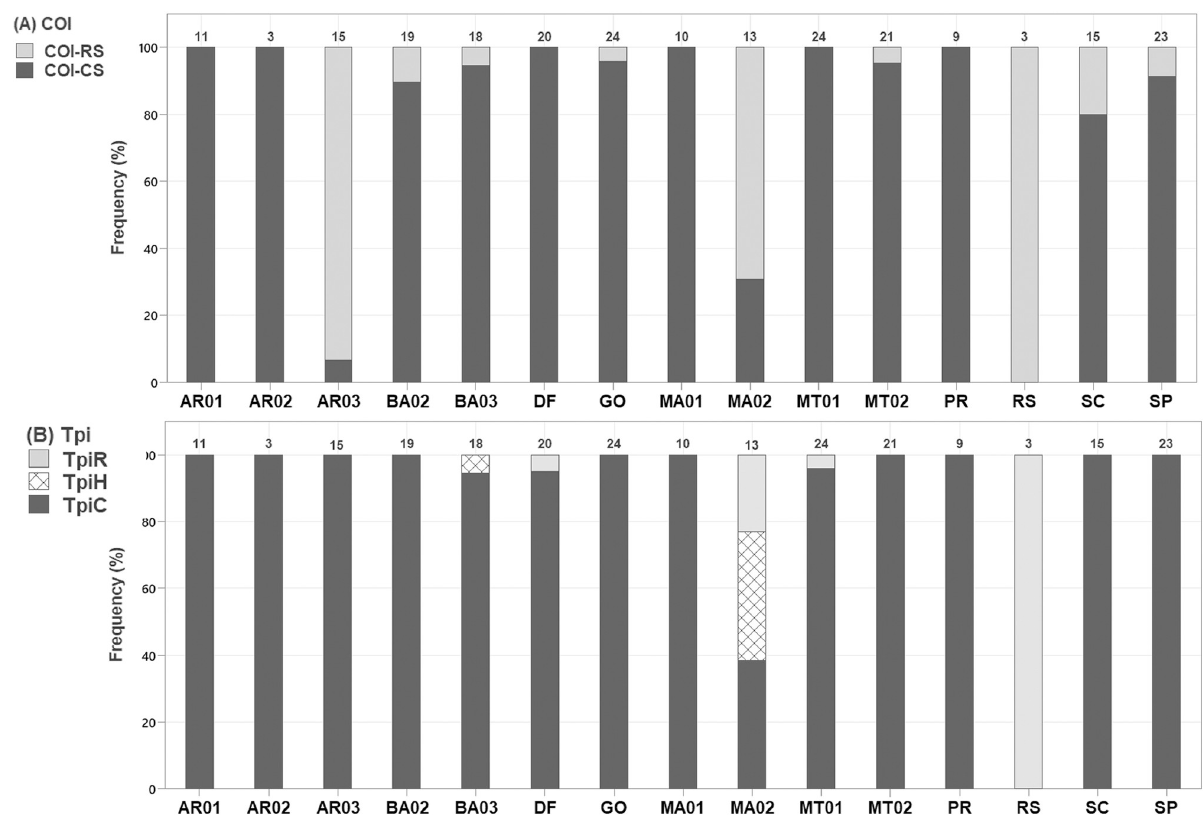
Fig 2. Haplotype frequencies in fall armyworm populations of Brazil and Argentina using COI and Tpi markers. A) COI strains COI-RS (R-strain) and COI-CS (C-strain) B) Tpi marker identifies R-strain ( Tpi R), C-strain ( Tpi C), and hybrids ( Tpi H) that feature both diagnostic polymorphisms at site